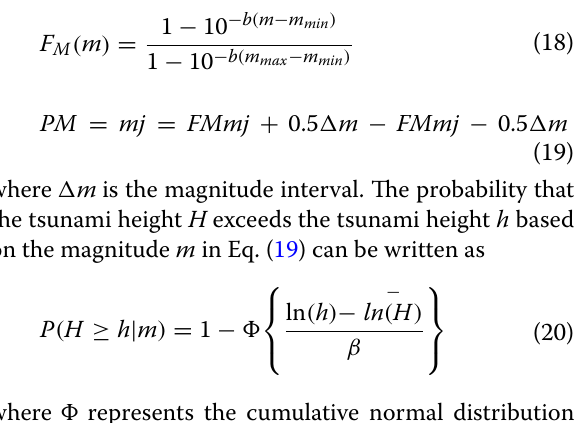
Sea level movement at the source of the tsunami for various scenarios is shown in Fig. 3. The red colour indi- cates a positive or rising wave, and the blue colour indi- cates a negative or down wave. The initial condition of the smallest tsunami wave occurs in scenario Mw 8.0, as shown in Fig. 3a, with a positive wave height of 3.40 m, + a negative wave height of 1.21 m, and which forms − a water column of 165 km in length. The largest